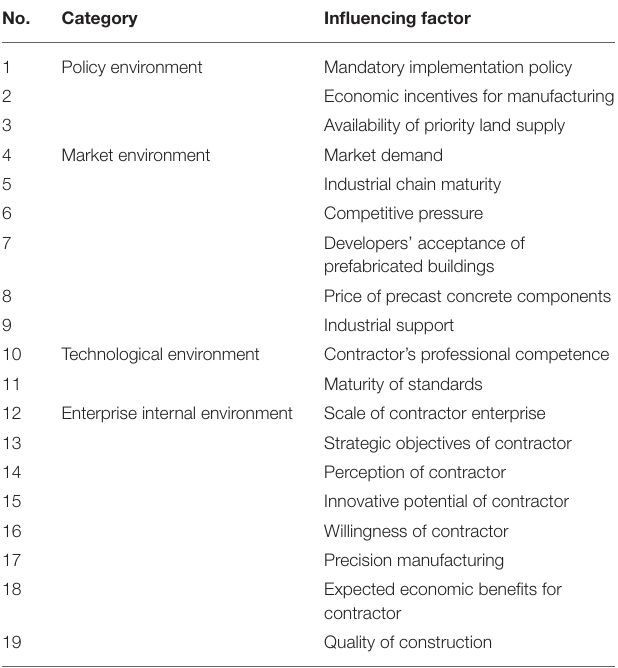
TABLE 1 | Summary of influencing